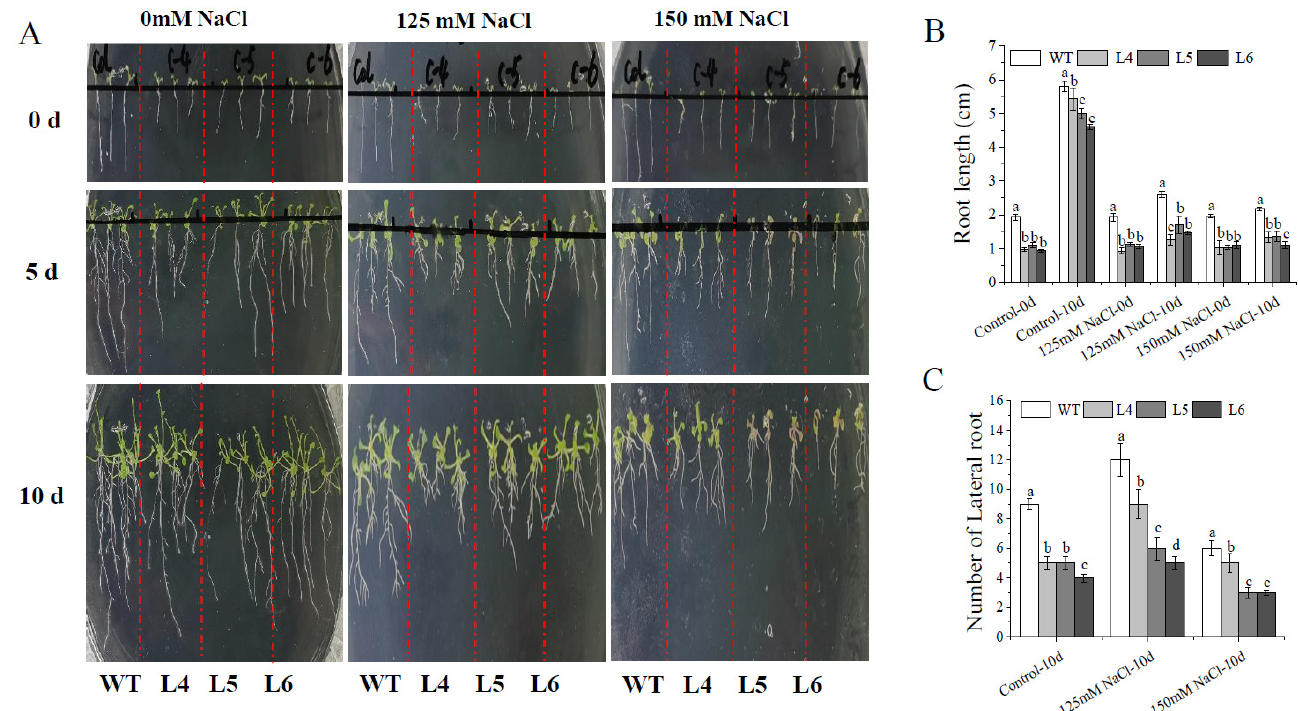
Figure 4. Phenotypes of the transgenic Arabidopsis and wild-type seedlings under 1/2 MS with different concentrations of NaCl: ( A ) seedlings growing on 1/2 MS with 0 mM, 125 mM, and 150 mM NaCl, respectively; ( B ) primary root length (cm); ( C ) number of lateral roots. Different letters indicate significant differences among L4, L5, L6, and WT under the same treatment ( p < 0.05). The seven-day-old seedlings of the wild-type plants (WT) and IbCCD 4-overexpressing T 3 lines (L4, L5, L6) were transplanted into soil, and after normal growth of 15 days, they were irrigated with 200 mM NaCl for salt stress treatment. Before treatment, there was no significant difference in the growth status and anthocyanin content in the rosette leaves among L4, L5, L6, and WT (Figure 5A, 0 d). After 7 days of salt stress treatment, the rosette leaves of the L4, L5, and L6 lines showed obvious purple, and their anthocyanin content was significantly higher than that of WT (Figure 5B).